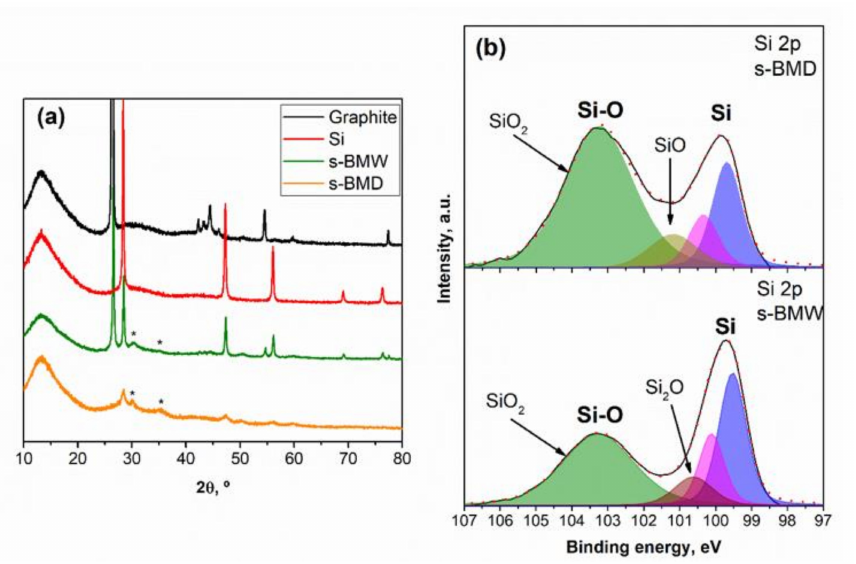
Figure 1. ( a ) X-ray di ff raction (XRD) patterns of silicon (Alfa Aesar), graphite, and ball milled samples (s-BMW and s-BMD). The asterisk represents SiO 2 . ( b ) X-ray photoelectron spectroscopy (XPS) spectra of the Si 2p region dry milled sample (s-BMD) and wet milled sample (s-BMW). Colors: blue and magenta (Si2p 3 / 2 and Si2p 1 / 2 , respectively), green (SiO 2 ), dark yellow (SiO), and purple (Si 2